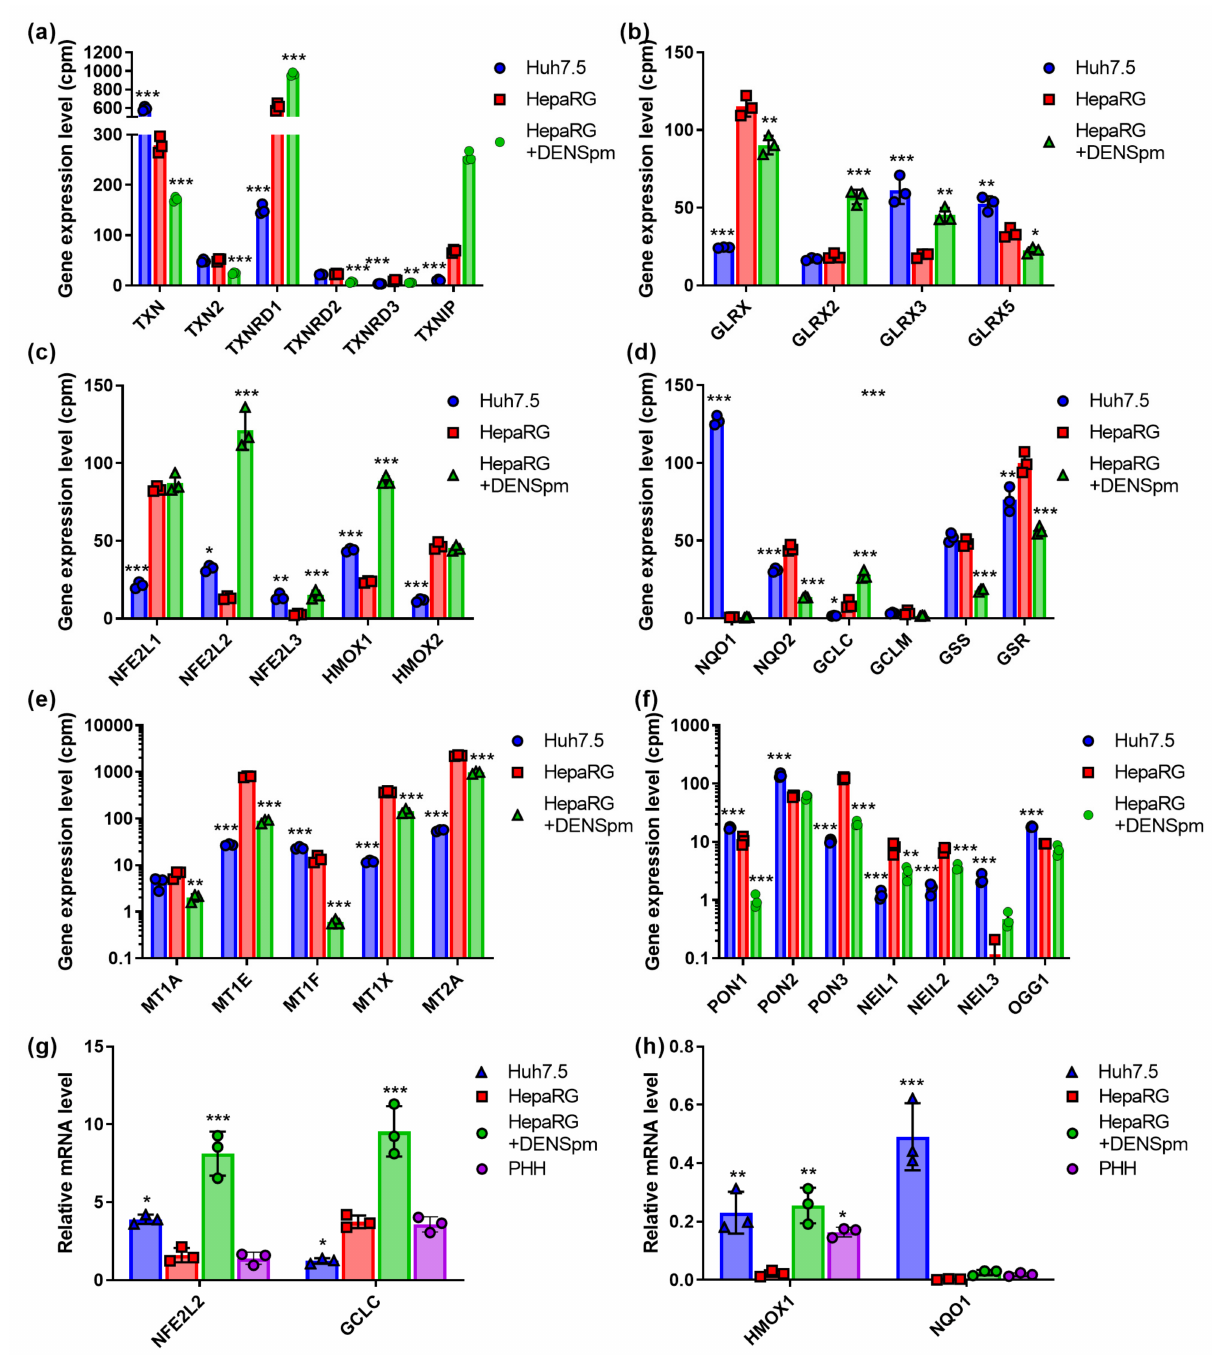
Figure 3. Relative mRNA levels of antioxidant enzymes and proteins that protect DNA and lipids from oxidative damage in hepatoma Huh7.5 cells, hepatocyte-like HepaRG cells, and in HepaRG cells treated with DENSpm, assessed by RNAseq analysis. Gene expression levels of thioredoxins (TRX) and thioredoxin reductases (TRXR) ( a ), glutaredoxins (GLRX) ( b ), Nrf2-dependent enzymes ( c,d ), metallothioneins (MT) ( e ), and paraoxonases (PON) and DNA glycosylases ( f ). ( g,h ) Relative levels of the mRNA of the antioxidant enzymes in these cells and PHH assessed by RT-qPCR and normalized to the levels of GUS mRNA. Bars are means ± S.D. Statistical significance was analyzed by ANOVA with Tukey’s post hoc test. Statistical significance is presented for the comparison of cells to differentiated HepaRG cells. * p < 0.05, ** p < 0.01, *** p <